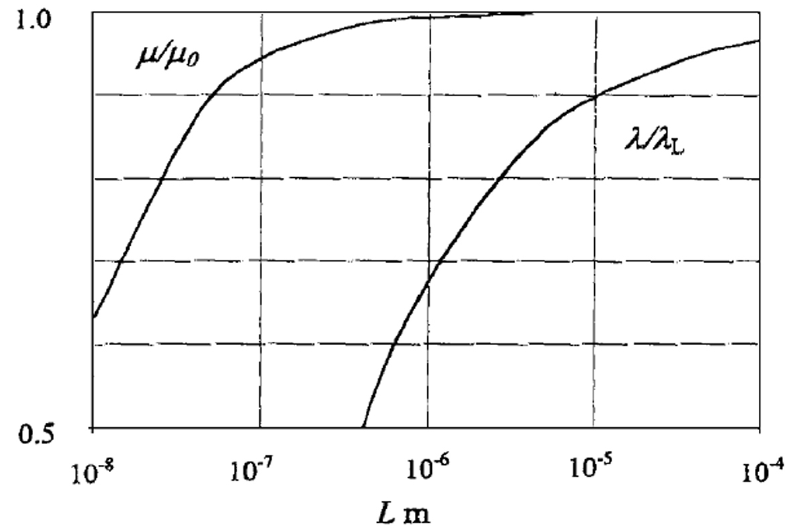
Figure 20. Boundary scattering in Zr Reference [136]. Copyright 2001, John Wiley and